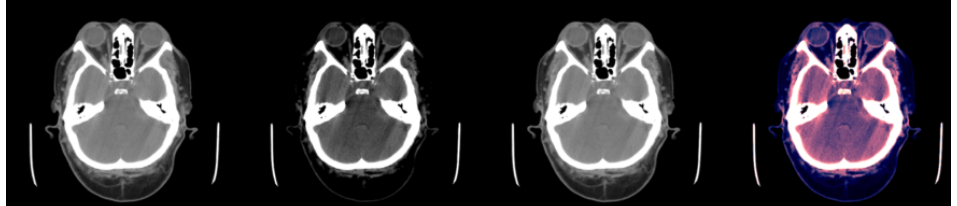
Figure 1. Example of slice windowing as pre-processing of an HU matrix to obtain three different matrices (window used between brackets). From left to right: (1) slice with [0.80], (2) slice with [ − 20, 180], (3) slice with [ − 150, 230], (4) the three windowed slices stacked (each channel is associated to one color RGB for visualization purposes).